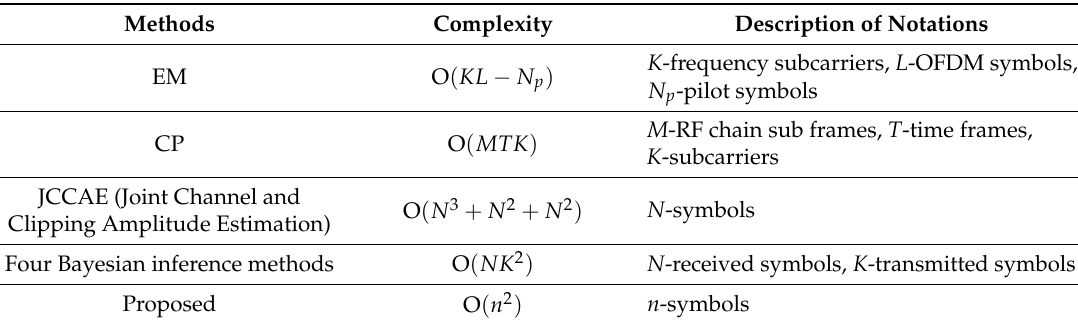
Table 4. Computational complexity analysis.